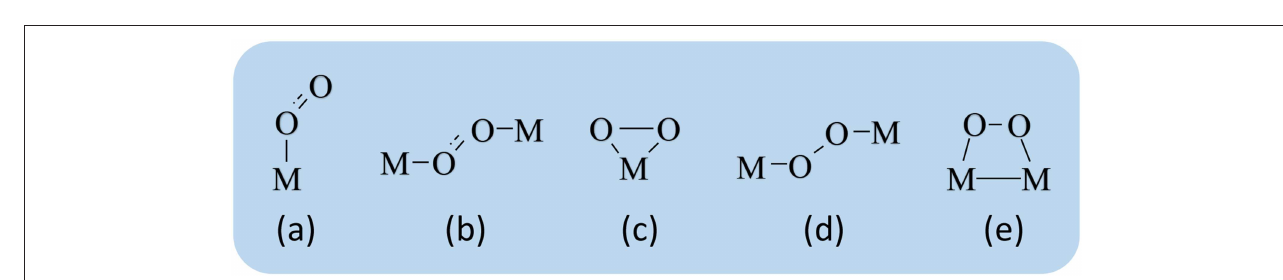
FIGURE 11 | The two types of bonding on the surface: (a) superoxo- η 1, (b) superoxo- µ , (c) η 2-peroxo, (d) µ -peroxo, and (e) trapezoid-peroxo (adapted from Wagnerová and Lang, 2011).